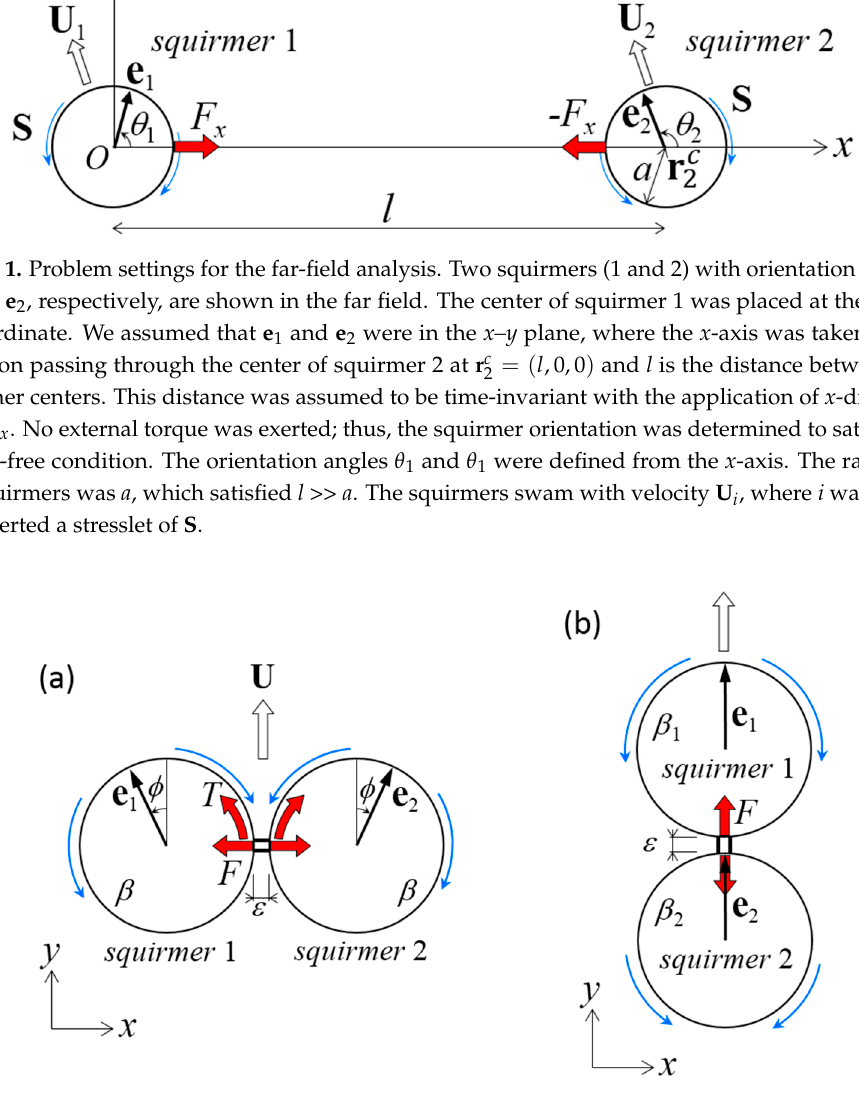
Figure 2. Problem settings for a dumbbell squirmer connected by a dragless rigid rod. The length of rod ε was set at 0.01 a . ( a ) Two identical squirmers with swimming mode β were placed side-by-side at an angle of φ from the y -axis. Due to the symmetry of the problem, the dumbbell swam in the y -direction with velocity U . The rod imparted the x -direction force F and the z -direction torque T to the squirmers. ( b ) Two squirmers with swimming modes β 1 and β 2 were placed fore and aft. The squirmers were oriented in the y -direction and swam in the y -direction at velocity U . The rod exerted the y -direction force F .